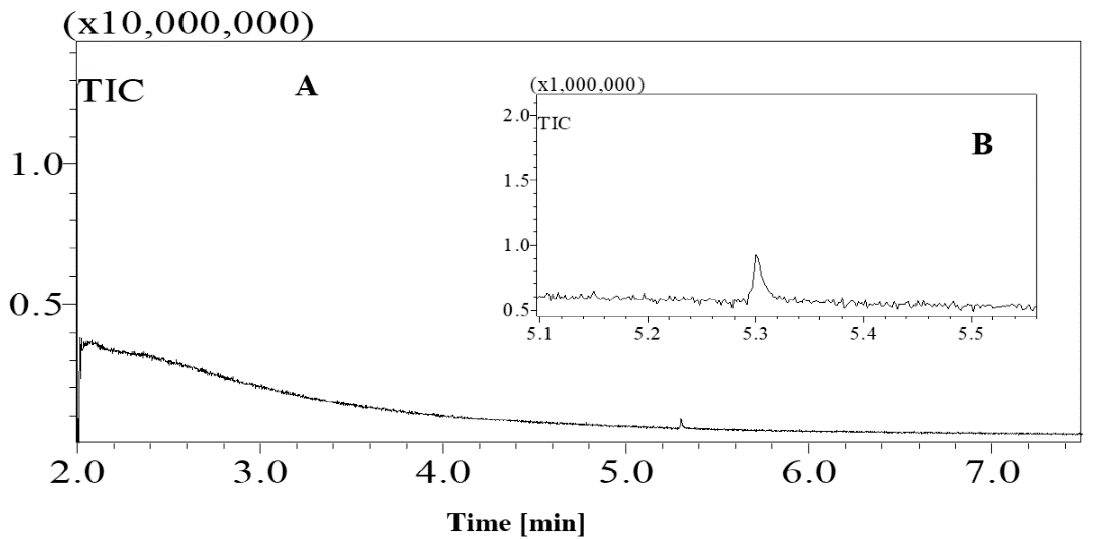
Figure 4. Total ion chromatogram (TIC) of standard sucrose. A chromatograph of a silylated sucrose sample. ( A ) Whole chromatogram of standard sucrose for a 7-min measurement; ( B ) chromatogram of standard sucrose from 5.1–5.5 min.